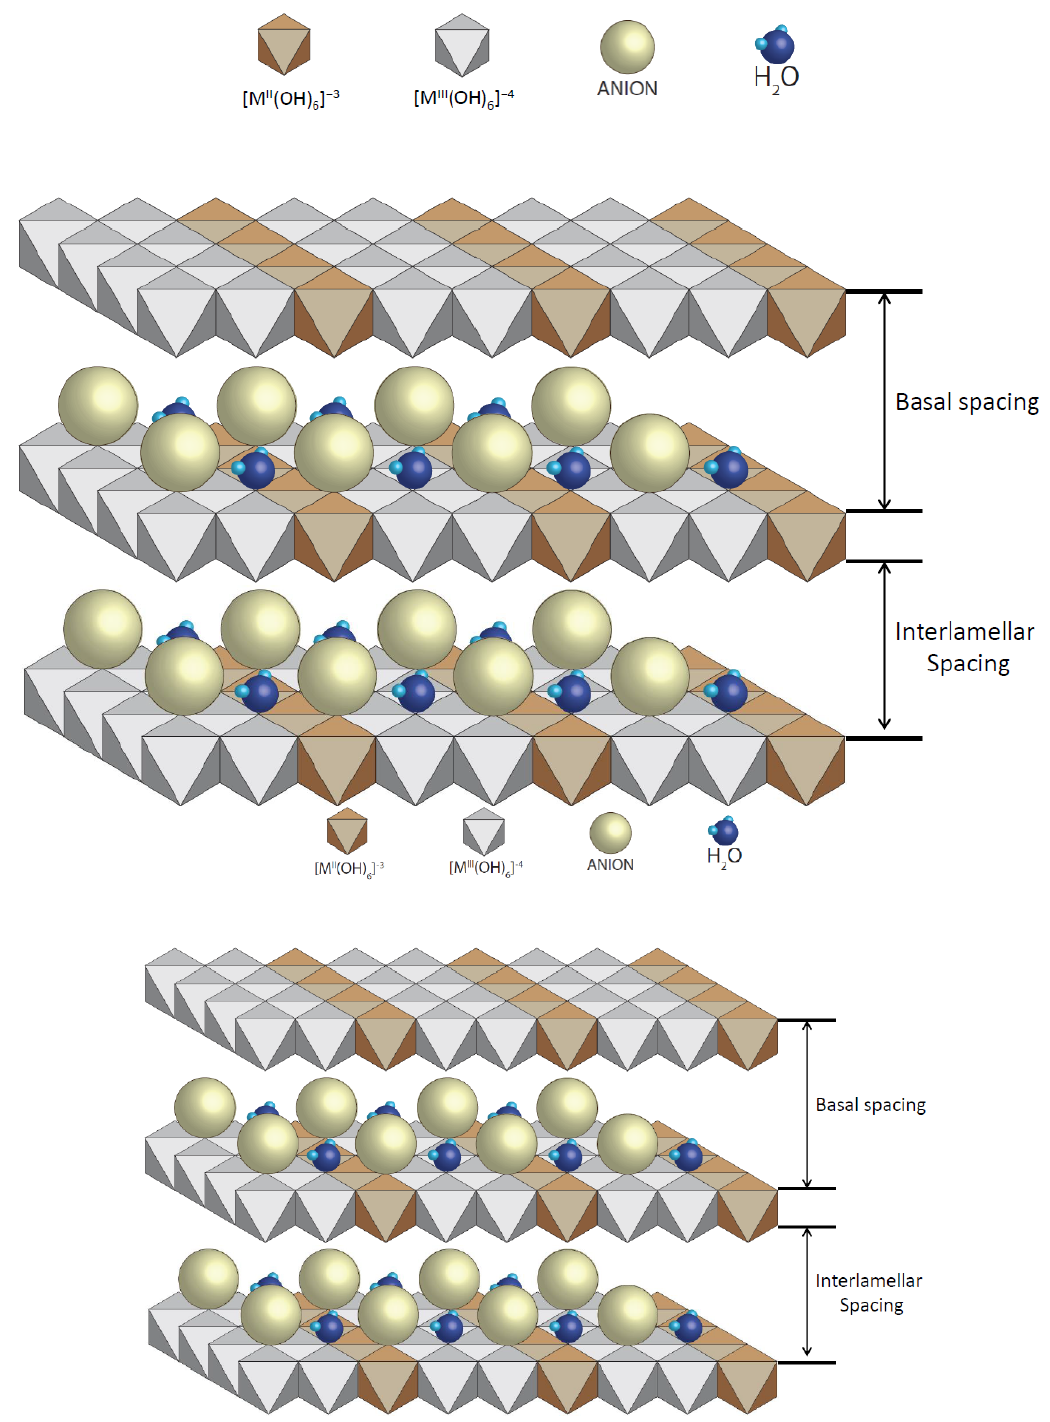
Figure 19. Basic structure of hydrotalcite